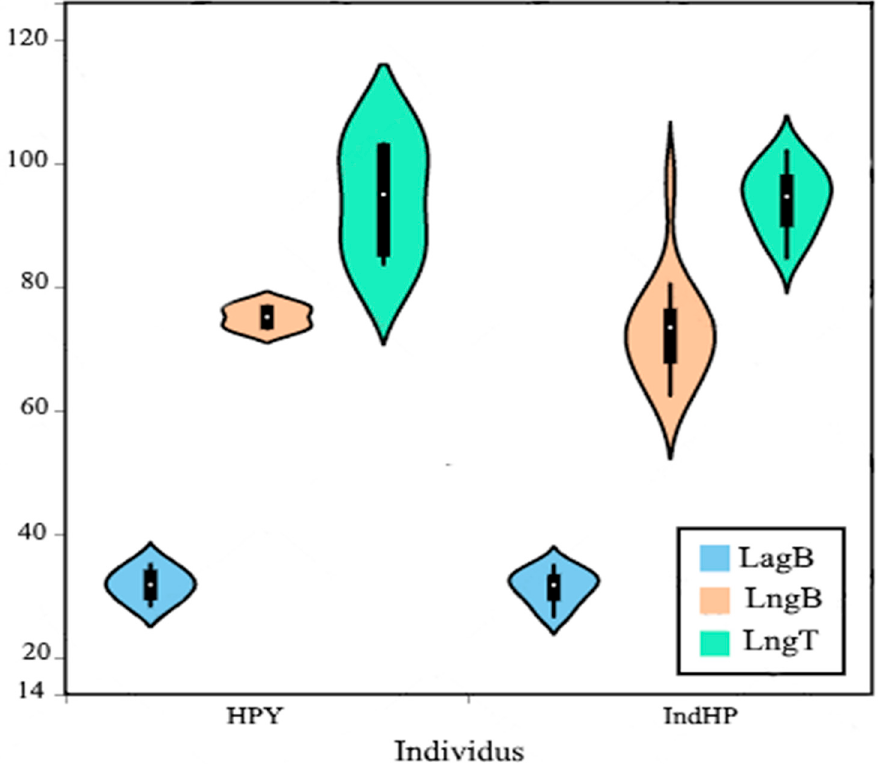
Figure 6. Analysis of the variables in the form of a violin plot. (LngB) Length of the ossicles in the shape of buttons, (LagB) width of the ossicles in the shape of buttons, (LngT) length of the ossicles in the shape of tables, and the distribution of the analyzed individuals on the figure (left: haplotype (HPY) and right: haplotype (IndHP)).